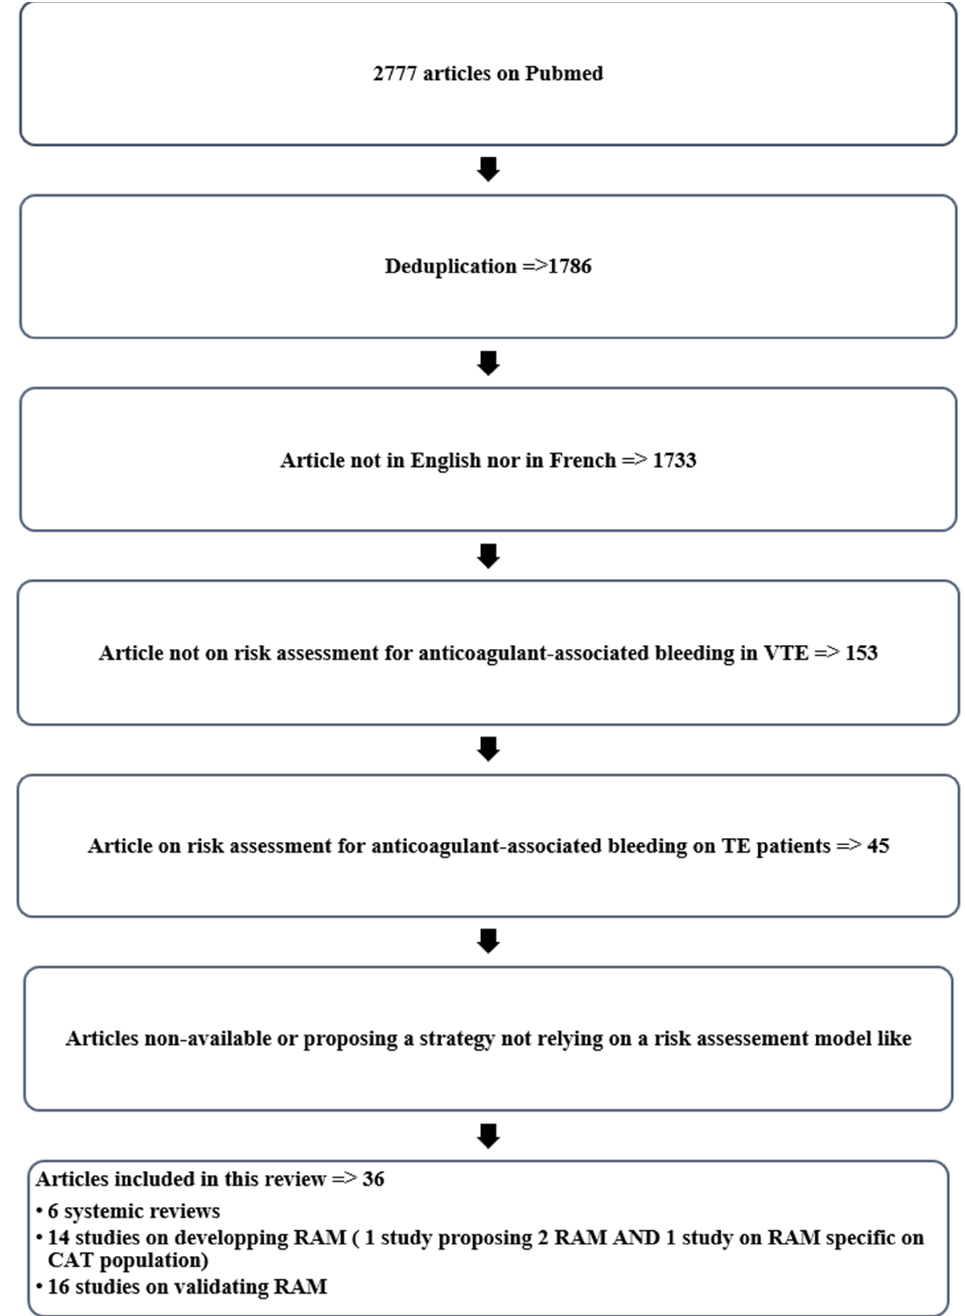
Figure 1. Flowchart of the study selection .